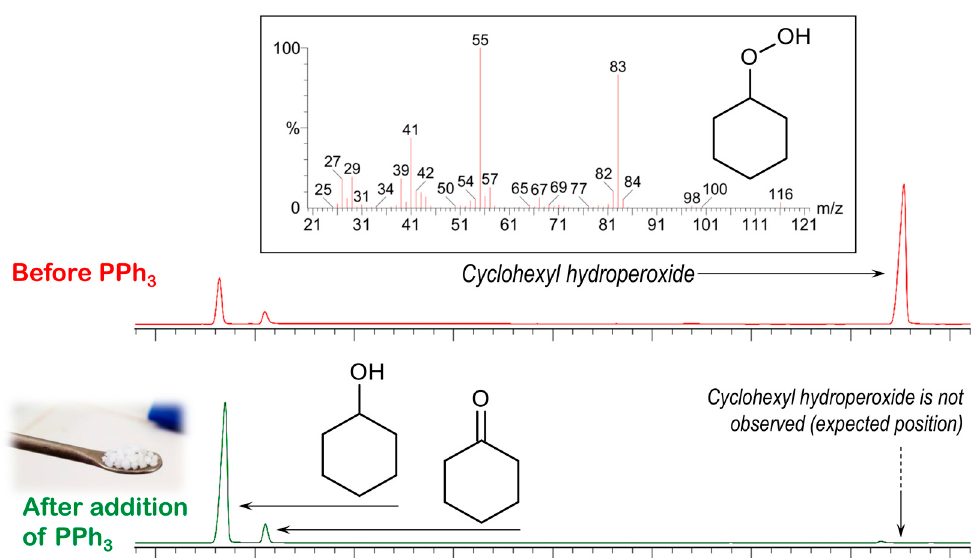
Figure 12. Fragment of the chromatogram of the reaction products in the oxidation of cyclohexane catalysed by 1 (conditions are as those stated in Figure 11 caption) at 1 h reaction time. The peaks of cyclohexanol and cyclohexanone, observed along with cyclohexyl hydroperoxide (top), represent the